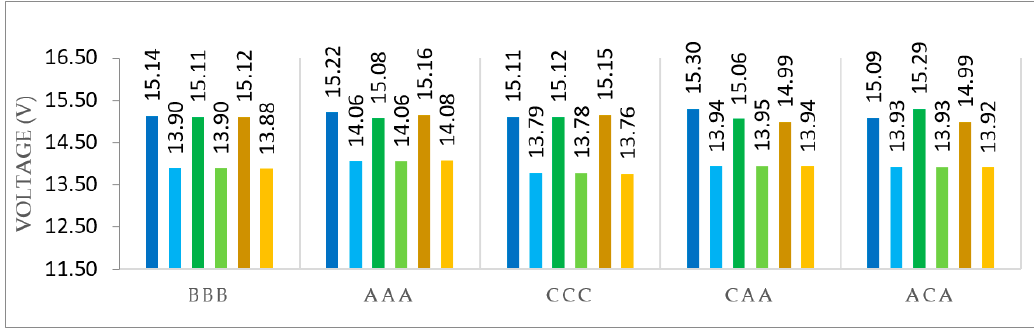
Figure 12. Voltage balance in CSCs depending on association at operating point N° 2 in ISOP config.